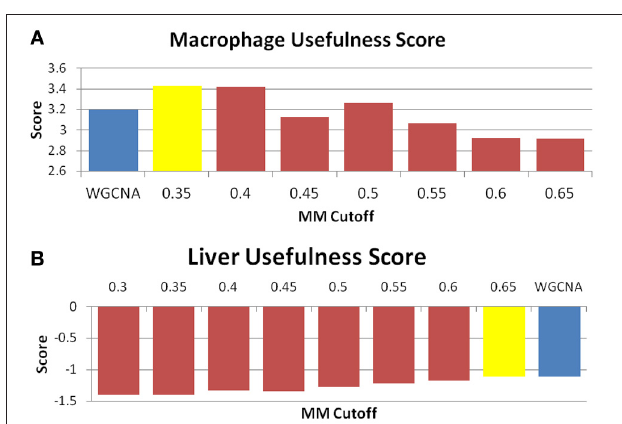
The black box indicates the region of preserved module eigengenes where correlation to one another and to the weighted PCA was greater than